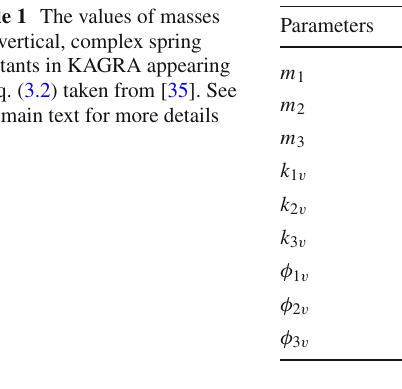
Table 1 The values of masses and vertical, complex spring constants in KAGRA appearing in Eq. (3.2) taken from [35]. See also main text for more details